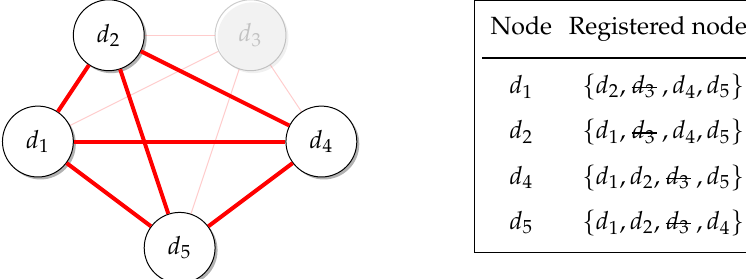
Figure 5. Failure of node d 3 . Listing 1: Cluster formation main